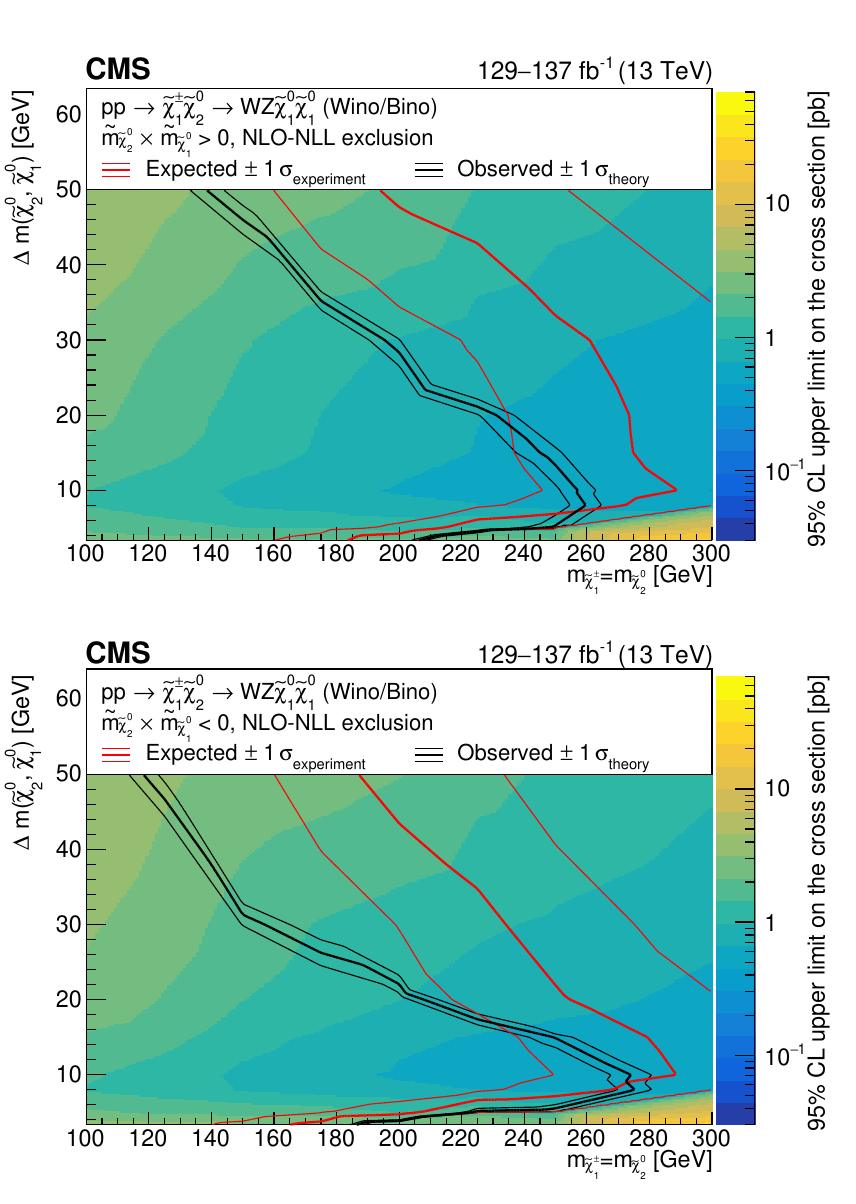
Figure 8 . The observed 95% CL exclusion contours (black curves) assuming the NLO+NLL cross sections, with the variations (thin lines) corresponding to the uncertainty in the cross section for the TChiWZ model. The red curves present the 95% CL expected limits with the band (thin lines) covering 68% of the limits in the absence of signal. Results are reported for the M ( ‘‘ ) spectrum reweighting scenario in the upper (lower) plot. The range of luminosities of the analysis regions included in the fit is indicated on the